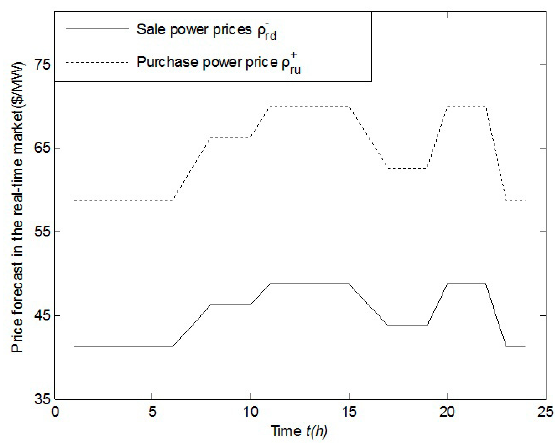
Figure 4. Purchase and sale power price forecasts in the real-time market.